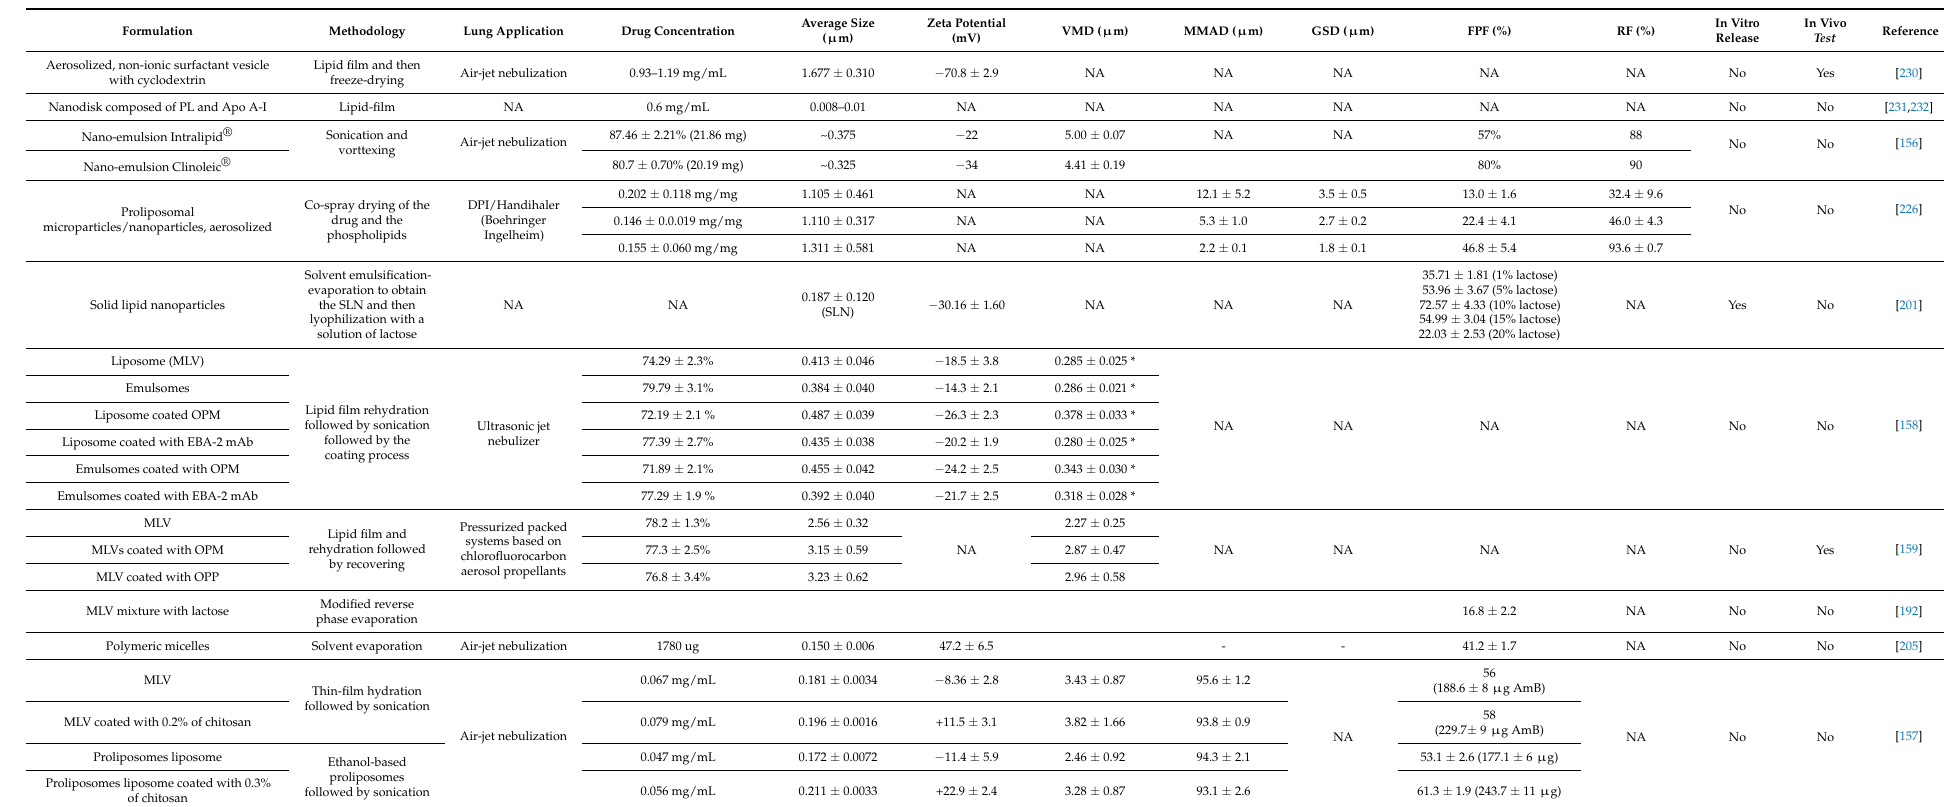
Table 2. AmB formulation for pulmonary delivery as described in the